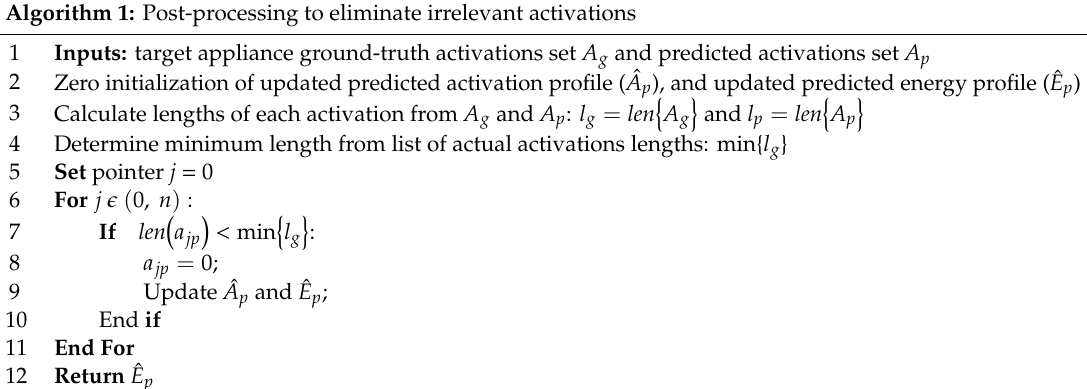
Table 1. Detailed Post-Processing Algorithm. Algorithm 1: Post-processing to eliminate irrelevant